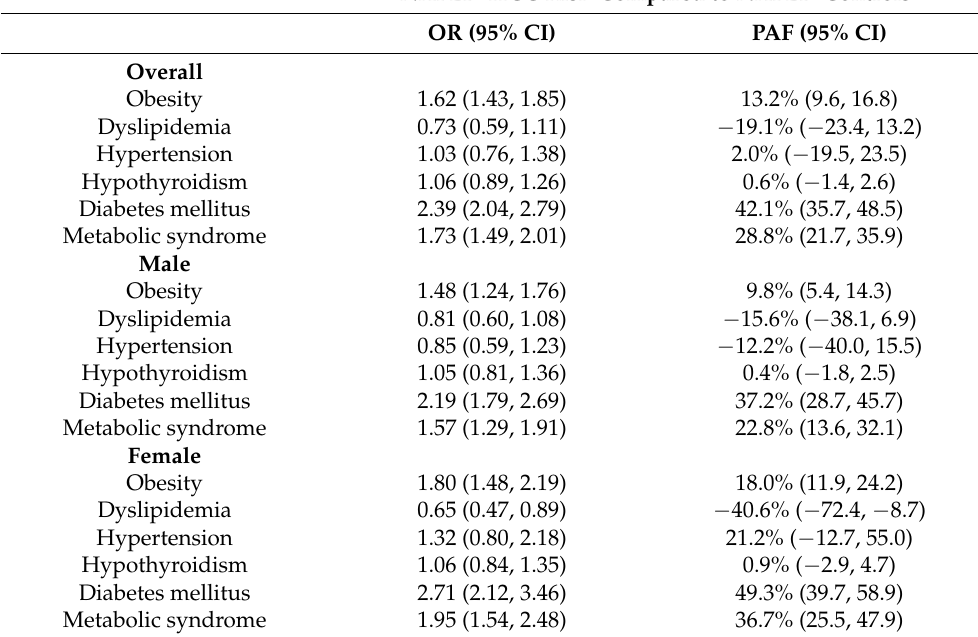
Table 3. Associations between metabolic risk factors and NAFLD-HCC risk, and population- attributable risk fractions for each metabolic risk for the overall samples, stratified by sex. NAFLD-HCC Risk Compared to NAFLD Controls OR (95% CI) PAF (95%